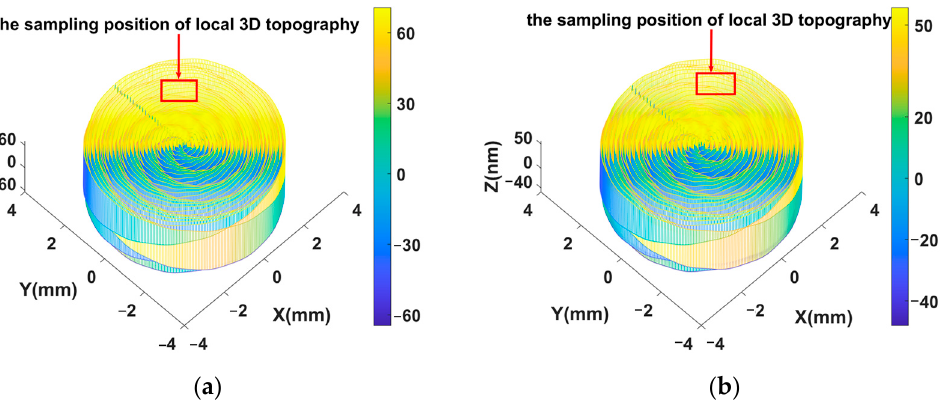
Figure 8. Entire 3D topographies of simulated results: ( a ) simulated surface with ap = 9 μ m, n = 1300